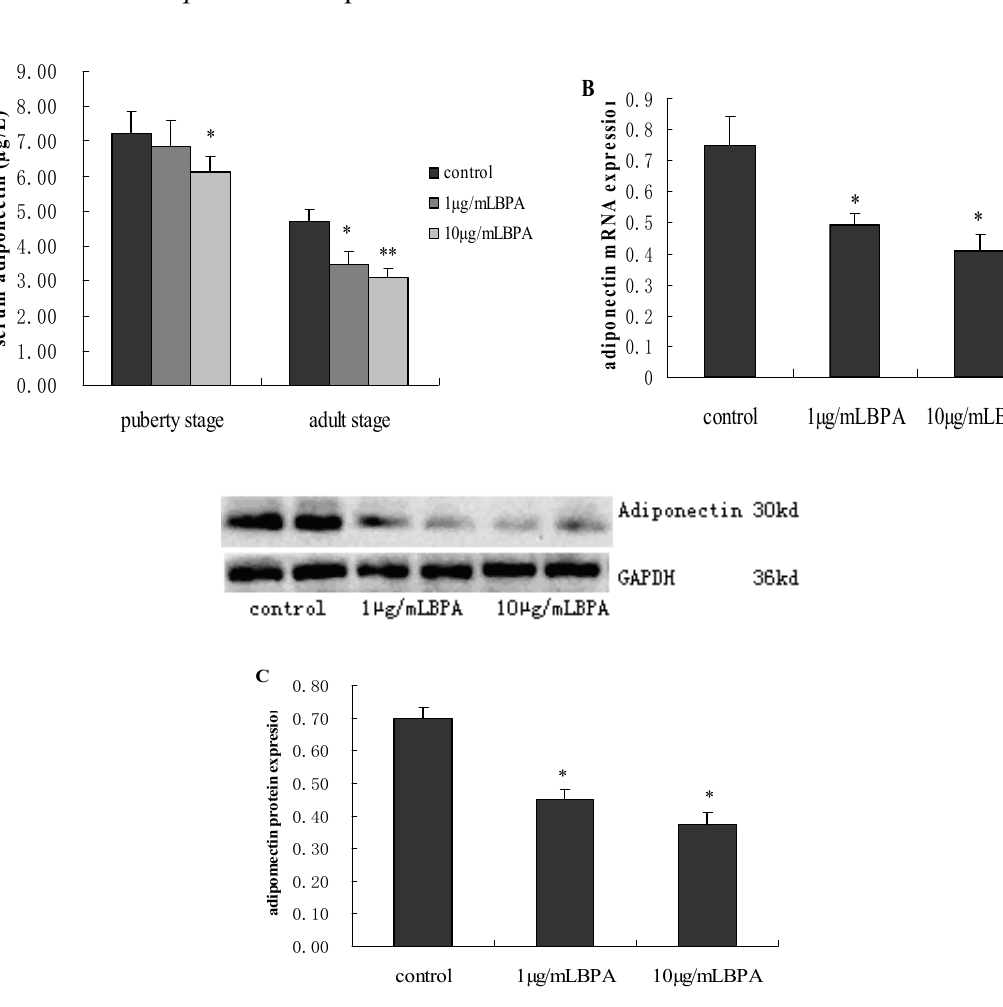
Figure 3. Effects of perinatal exposure to BPA on adiponectin (ADP) production from blood or subcutaneous adipose tissue of male offspring at their puberty and adult stage. Pregnant rats ( n = 7/group) were exposed to vehicle or BPA in water at levels of 1 or 10 µg/mL from gestation day 6 through the end of lactation. Serum ADP level was measured by ELISA kits ( A ) The levels of adiponectin mRNA ( B ) and protein ( C ) expression in subcutaneous adipose tissue were measured by Real-time PCR and western blotting respectively. Values represent the mean ± SE ( n = 7, one from each group). * p < 0.05 and ** p < 0.01 compared with